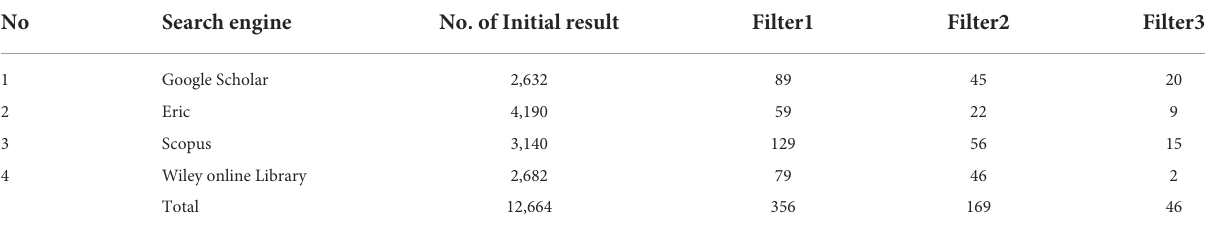
TABLE 2 Overall search result according to the search